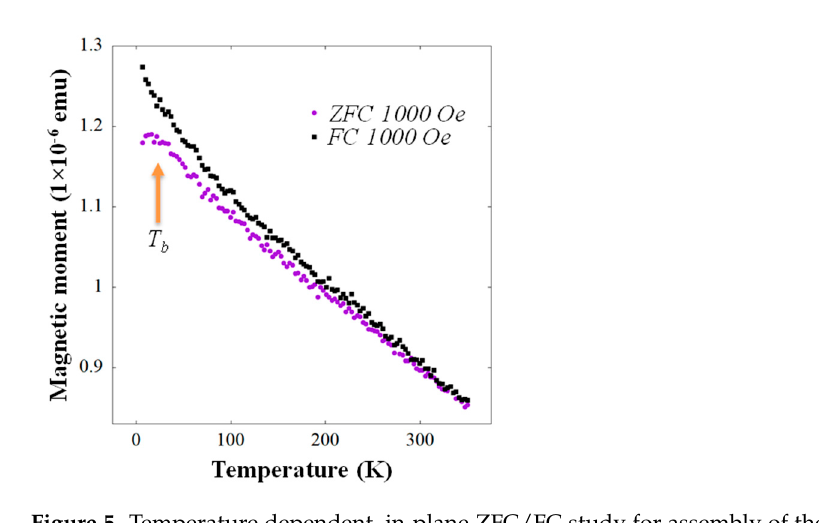
Figure 5. Temperature dependent, in-plane ZFC/FC study for assembly of the γ phase NSs with application of external magnetic field 1000 Oe.